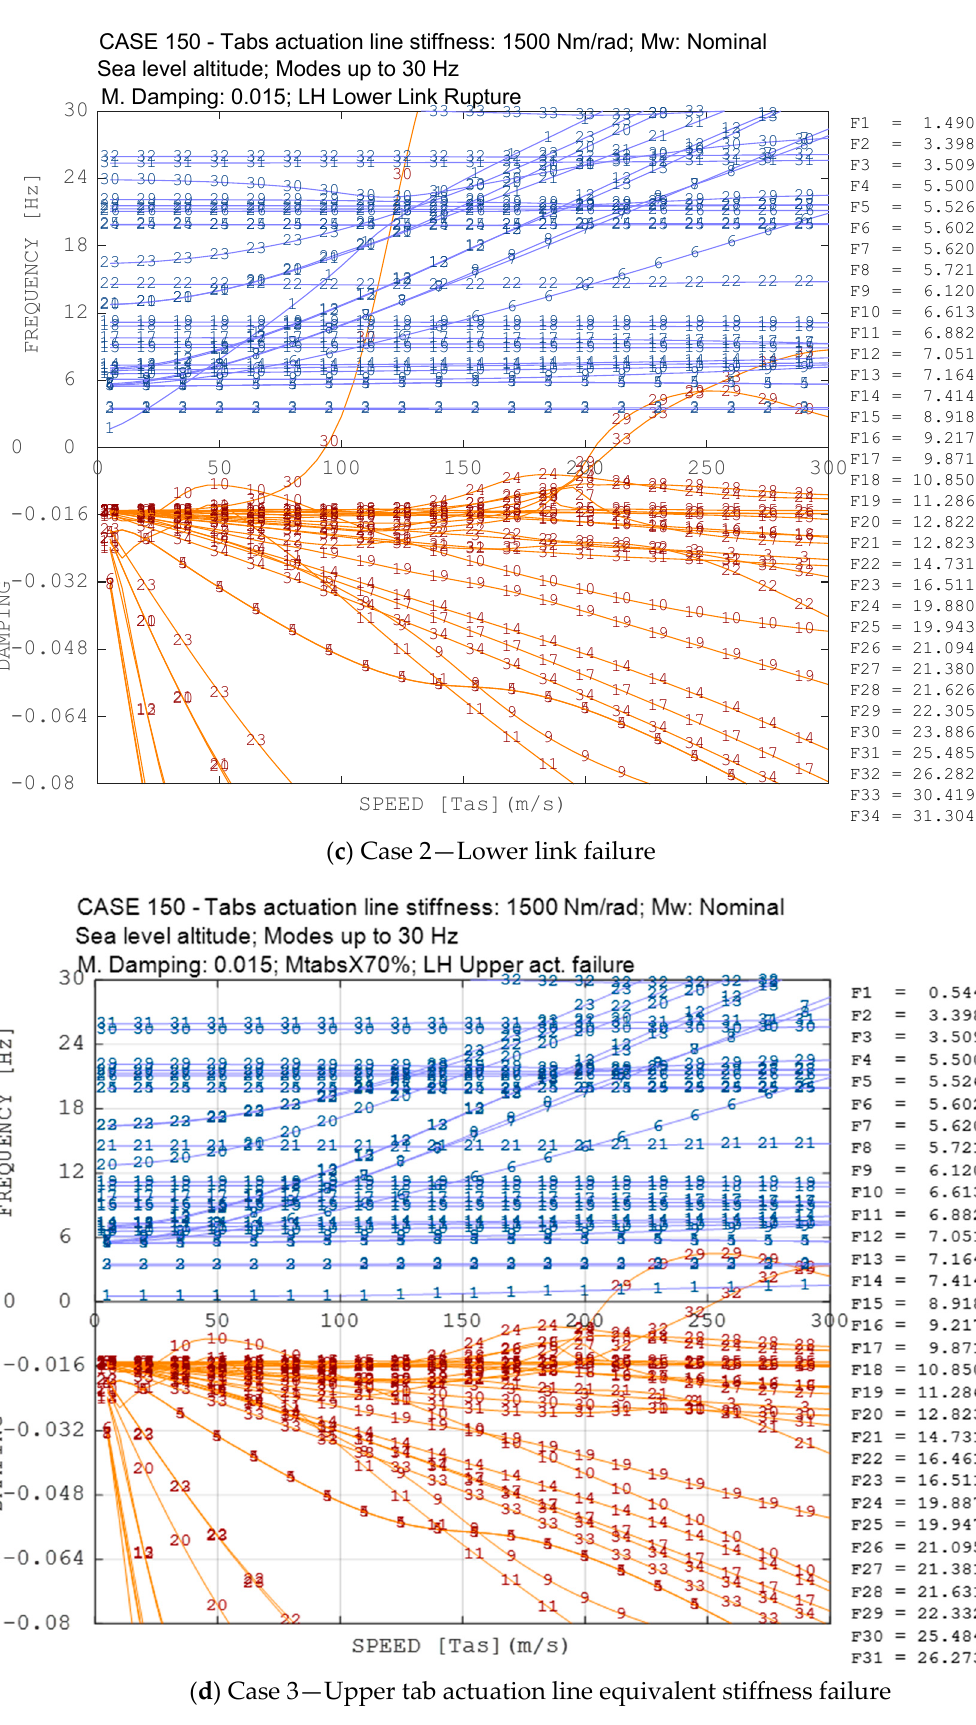
( d ) Case 3—Upper tab actuation line equivalent stiffness failure Figure 13.